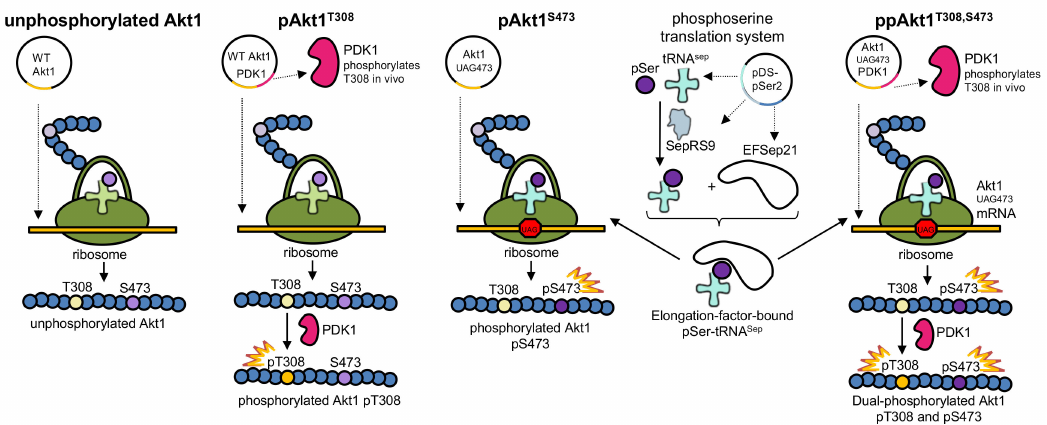
Figure 1. Production of Akt1 variants with programmed phosphorylation. To produce pAkt1 T308 , PDK1 (Akt1’s natural upstream kinase) was co-expressed along with Akt1. To produce pAkt1 S473 , the phosphoserine orthogonal translation system was used to genetically incorporate phosphoserine at position 473 in response to an amber (UAG) codon. The ppAkt1 T308,S473 variant was produced by combining both methods. WT: wild